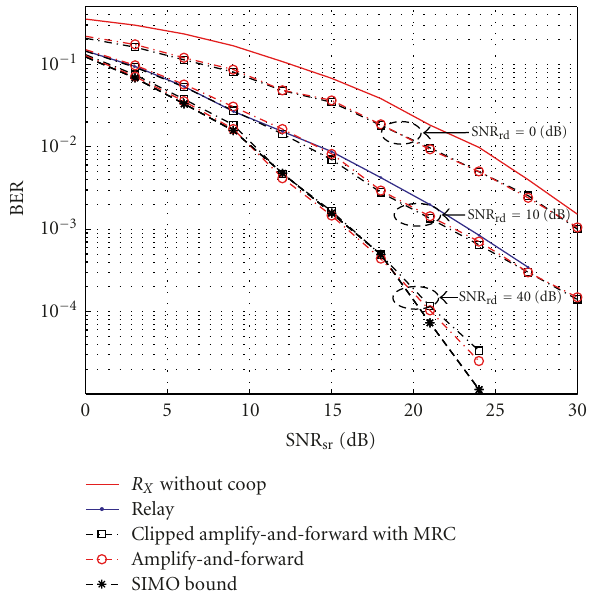
Figure 5: Comparison between the AF and clipped AF protocols in quasistatic channels for SNR sr = SNR sd +